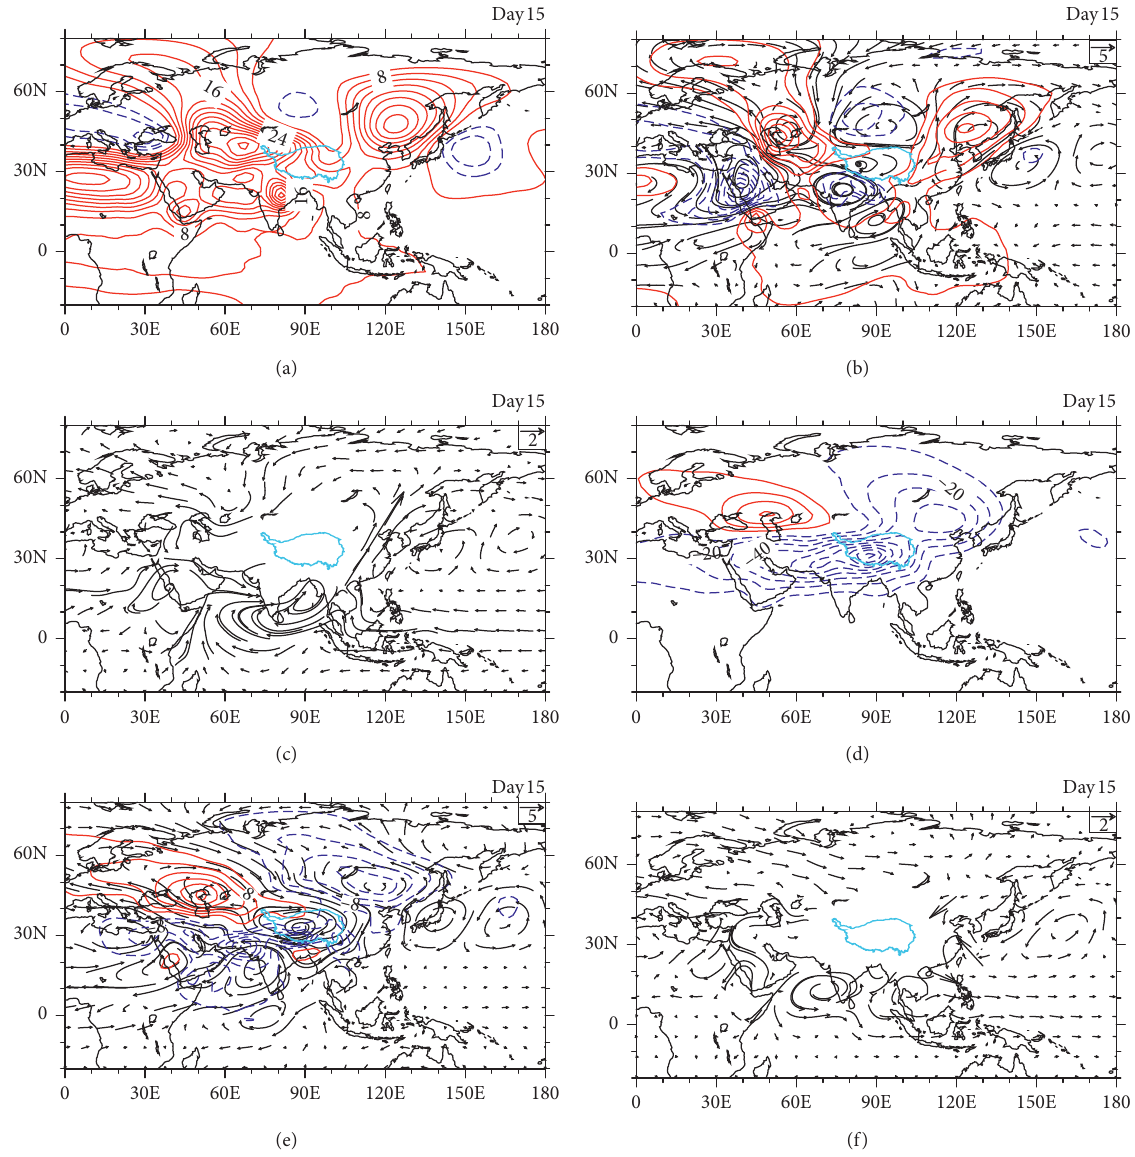
Figure 7: (a) Steady 200hPa height anomalies (contours, unit: gpm), (b) 500hPa height (contours, unit: gpm) and winds (vectors, unit: m · s − 1 ) anomalies, and (c) 850hPa winds anomalies (vectors, unit: m · s − 1 ) generated by INH experiment, (d)–(f) is as (a)–(c), but for TPC